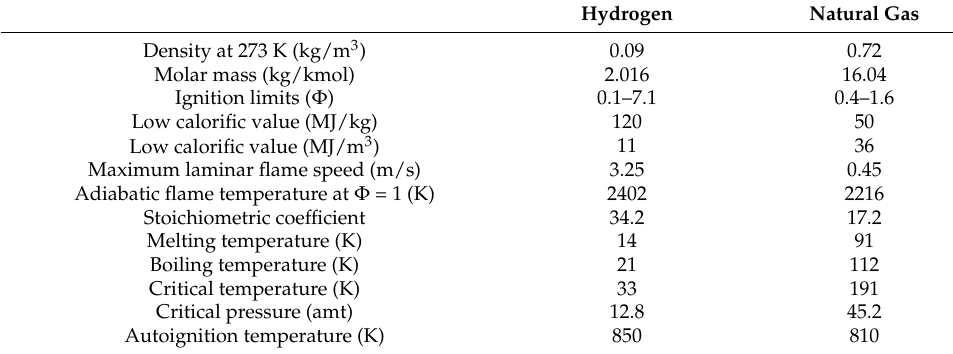
Table 1. Properties of hydrogen compared to natural gas [4–7].